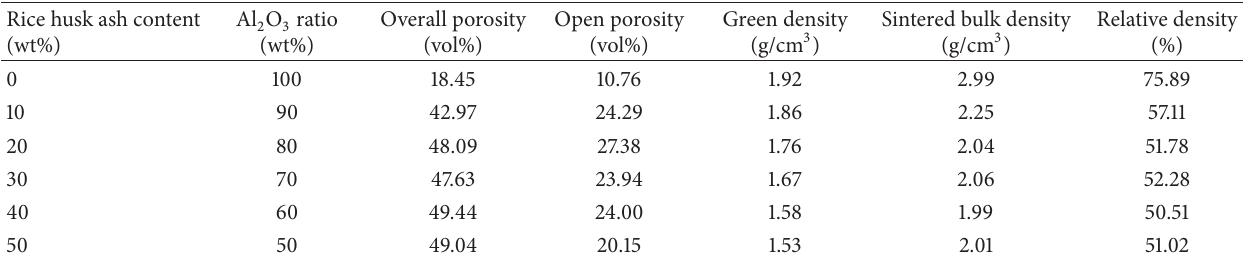
Table 2: Different ratios of rice husk ash with alumina used to fabricate porous ceramics, porosity characterization, and density. Rice husk ash